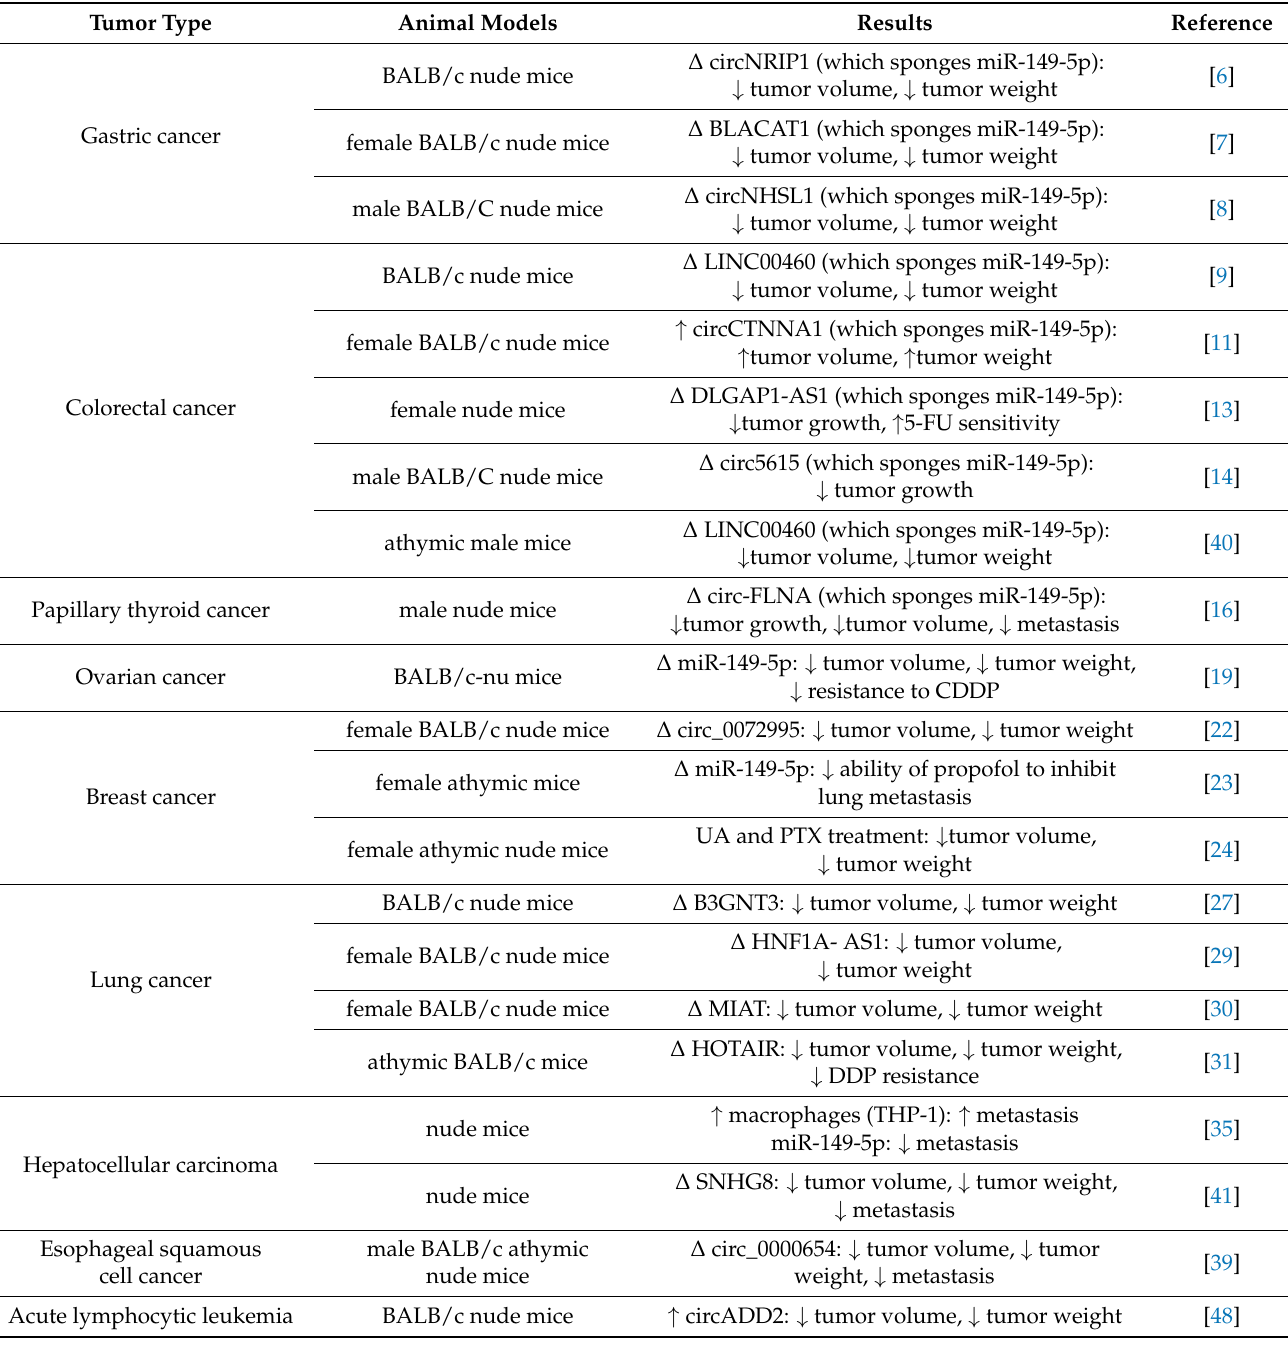
Table 2. Role of miR-149-5p or miR-149-5p-intercating genes in the carcinogenesis based on ani- mal models ( ∆ : knock-down or deletion, ↑ : up-regulation or enhancement, ↓ :